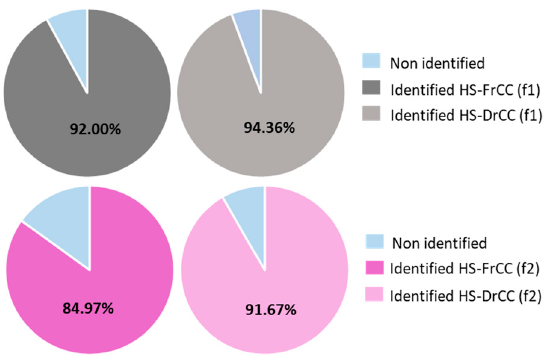
Figure 1. Diagram showing the portion of identified compounds in the headspace of C. corniculata . HS-FrCC—headspace of fresh C. corniculata ; HS-DrCC—headspace of air-dried C. corniculata ; f1— DVB/CAR/PDMS fibre; f2—PDMS/DVB fibre.